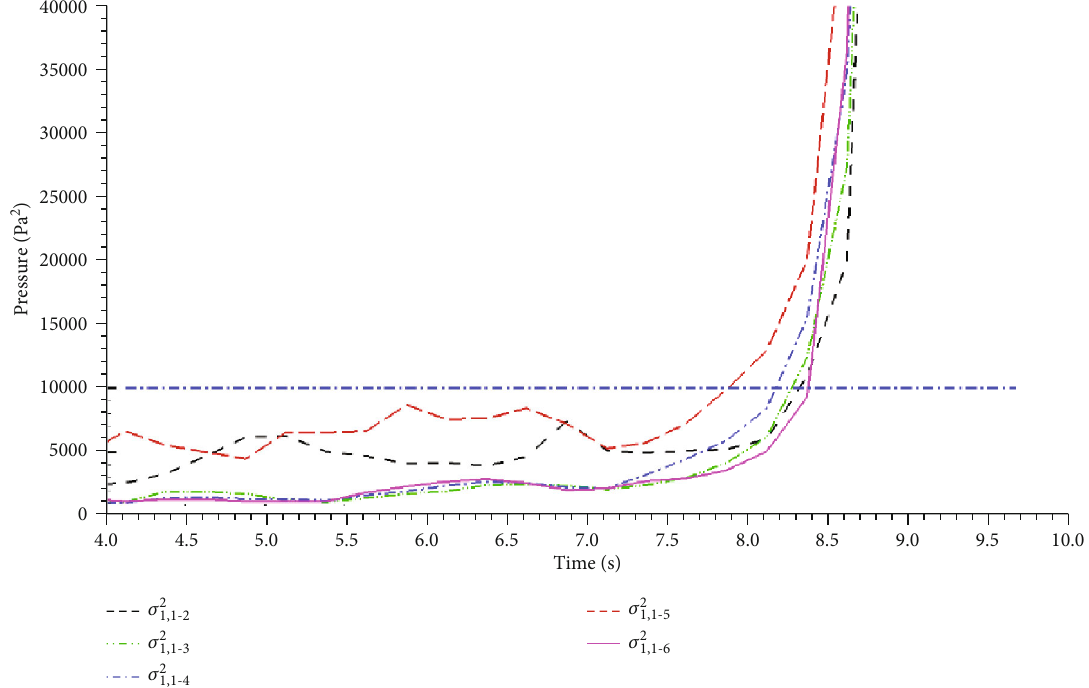
Figure 13: Analysis results of the heterotopic variance with di ff erent combinations of measuring